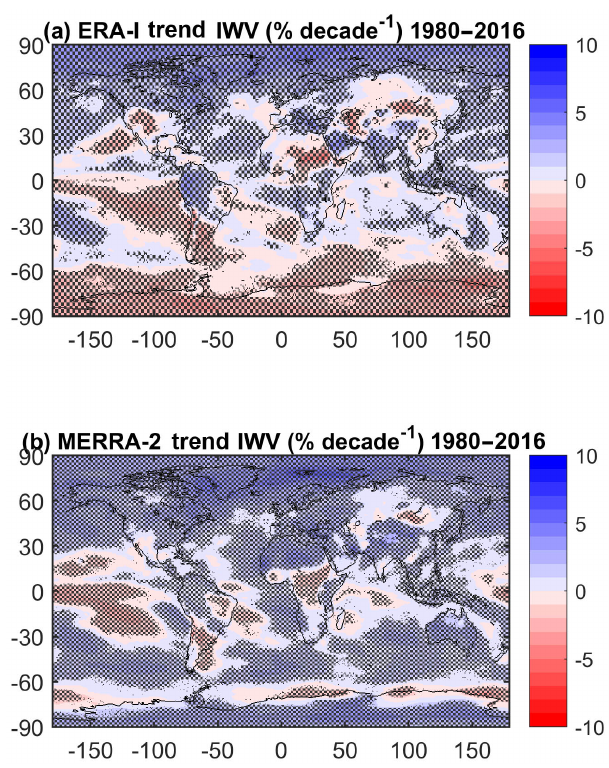
Figure 7. Monthly trends in IWV for the 1980–2016 period for (a) ERA-Interim and (b) MERRA-2. The statistically significant trends are highlighted by